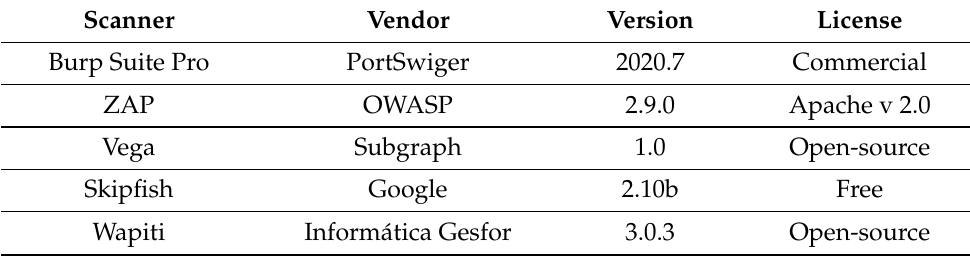
Figure 1. Our five-step approach. Table 2. General characteristics of the tested